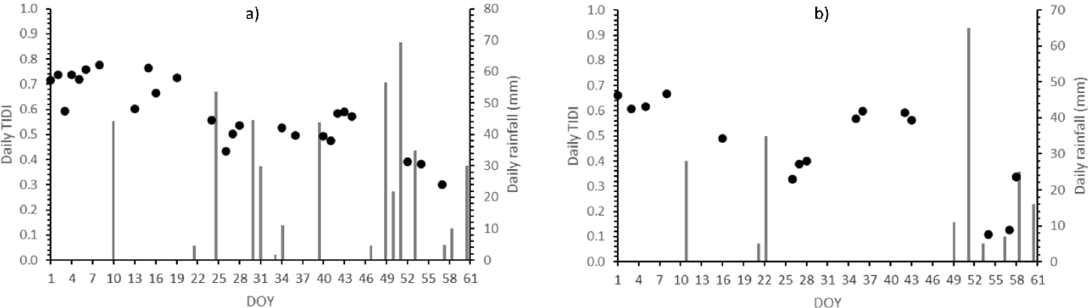
Figure 10. Daily TIDI as a function of time for ( a ) La Ydalina and ( b ) Tandil stations during the analyzed period.